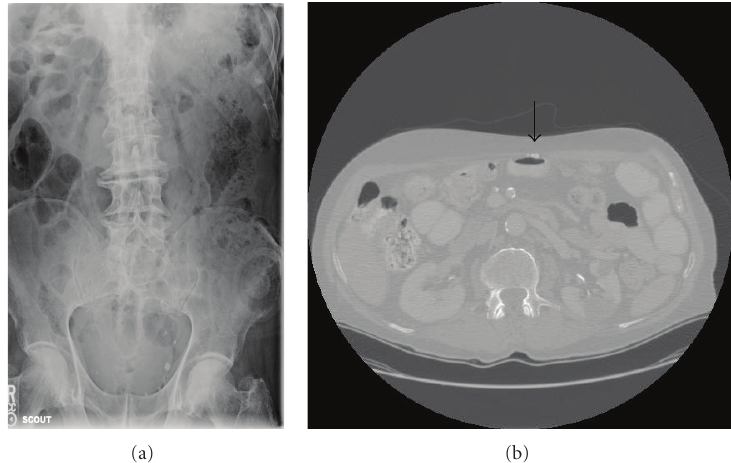
Figure 3: Preoperative abdominal showing (a) no evidence of heterotopic ossification on abdominal plain film. However, there is clear (b) evidence of heterotopic ossification in the lower midline abdominal scar adjacent to bowel wall seen on abdominal CT (computerized tomography) scan. Arrow denotes heterotopic